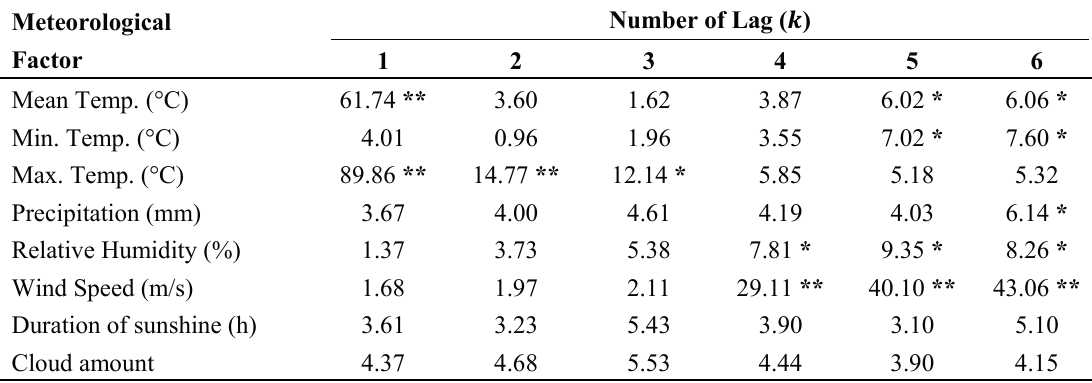
Table 1. Granger causality result with scrub typhus and detrended meteorological factors.